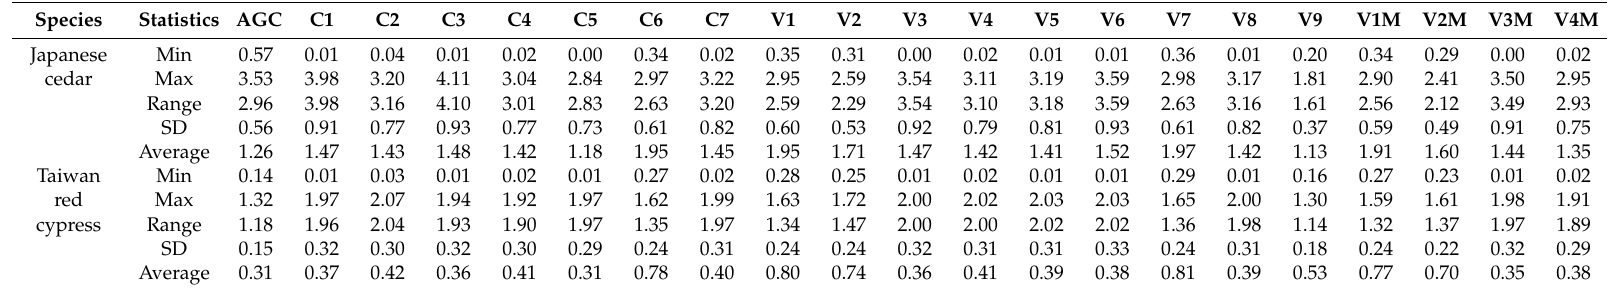
Table 4. A comparison of the descriptive statistics of tree-level AGC between the observations and model